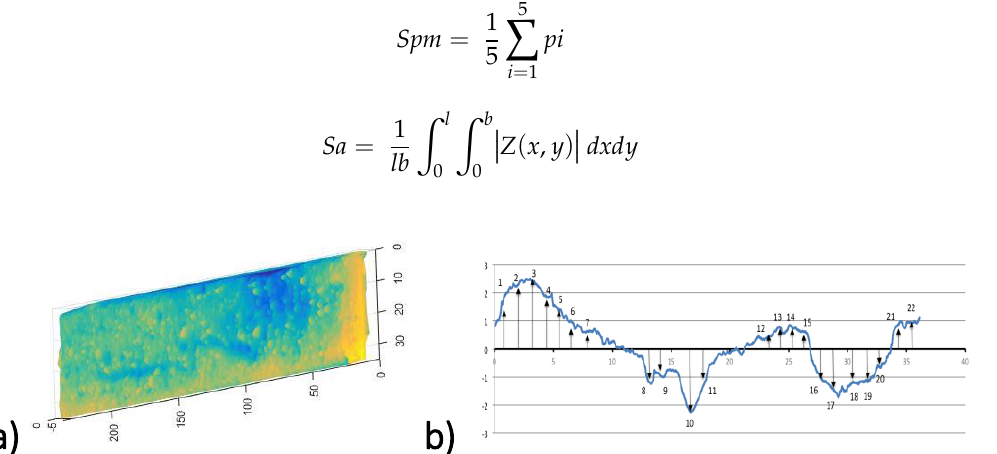
Figure 3. ( a ) Representative three-dimensional (3D) topography of a substrate profile after sandblasting and prior to the repair application and ( b ) two-dimensional (2D) profiles used to calculate crack deviation in monolithic, material tests .